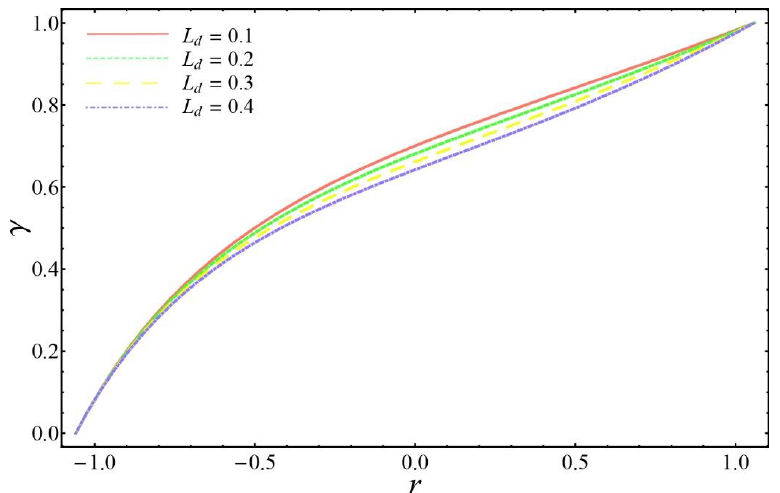
Figure 10. Alteration of k on γ when 𝑥 = 0.1; 𝑡 = 0; 𝑄 = 10; 𝛽 = 0.2; 𝜖 = 0.1; 𝑁 𝑏 = 2; 𝑁 𝑑 = 1; 𝐿 𝑑 = 0.1.